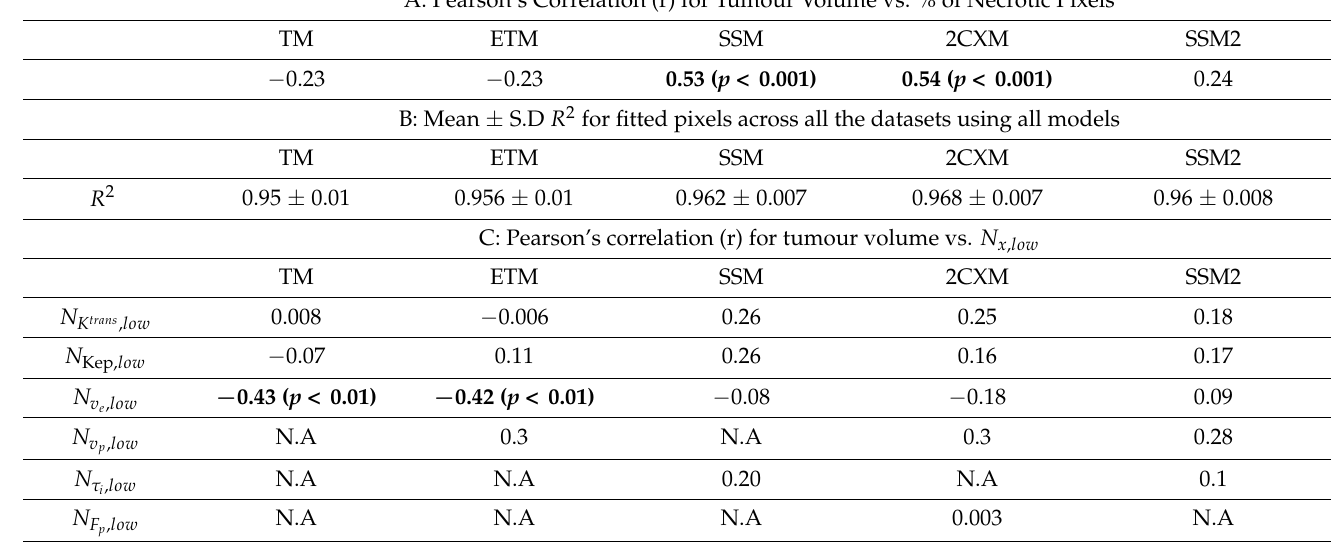
Table 1. Pearson’s correlation ( r ) for tumour volume vs. necrotic pixels (A), R 2 for fitted pixels across all the datasets using all models (B) and Pearson’s correlation ( r ) for tumour volume vs. N x , low (C).